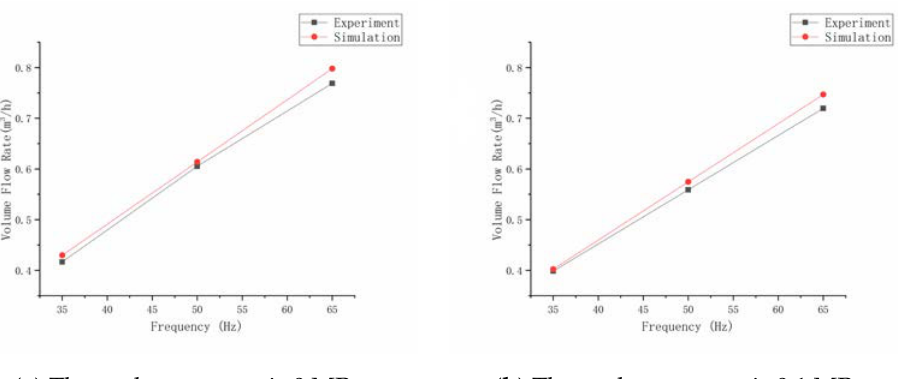
Figure 8. Flow curve of experimental and simulation results.